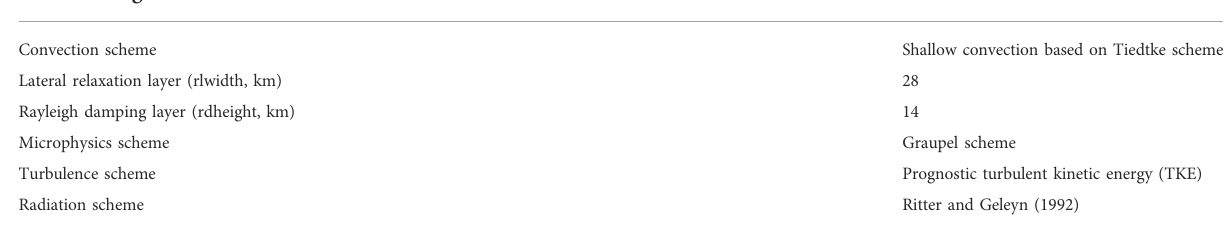
TABLE 2 Basic model con fi guration parameters for COSMO.